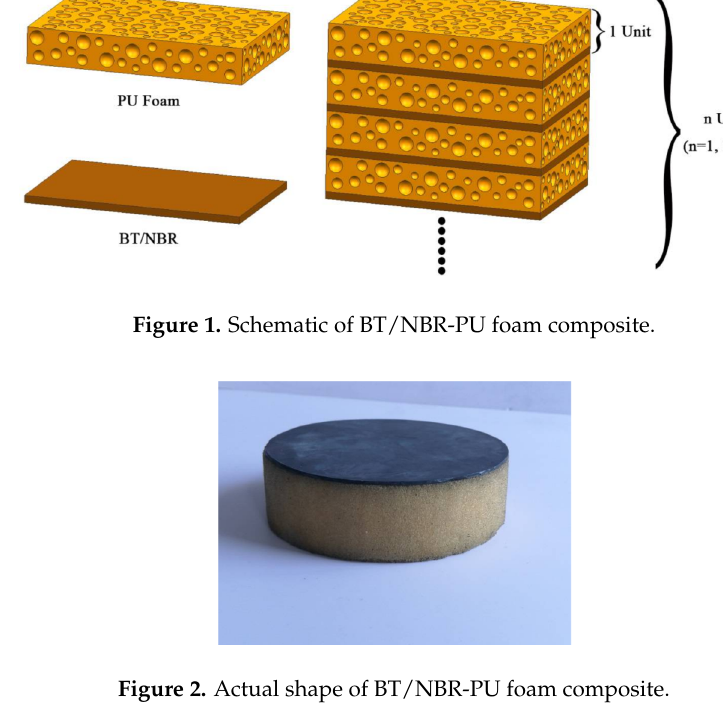
Figure 2. Actual shape of BT/NBR-PU foam